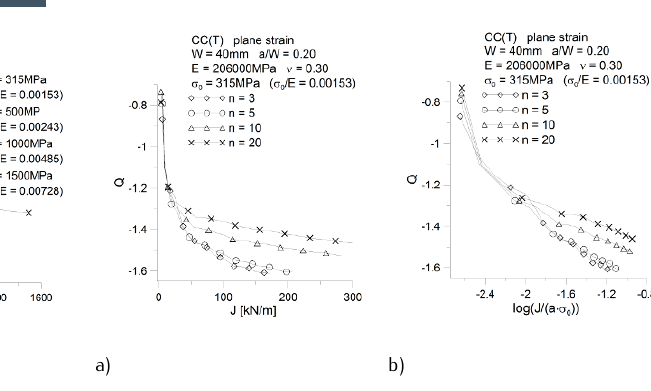
Figure 9. The influence of the yield stress on J - Q trajectories for CC(T) and SEN(T) specimens for a / W =0.50, n =10 (plane strain for distance from crack tip r =2.0 · J / σ 0 ).